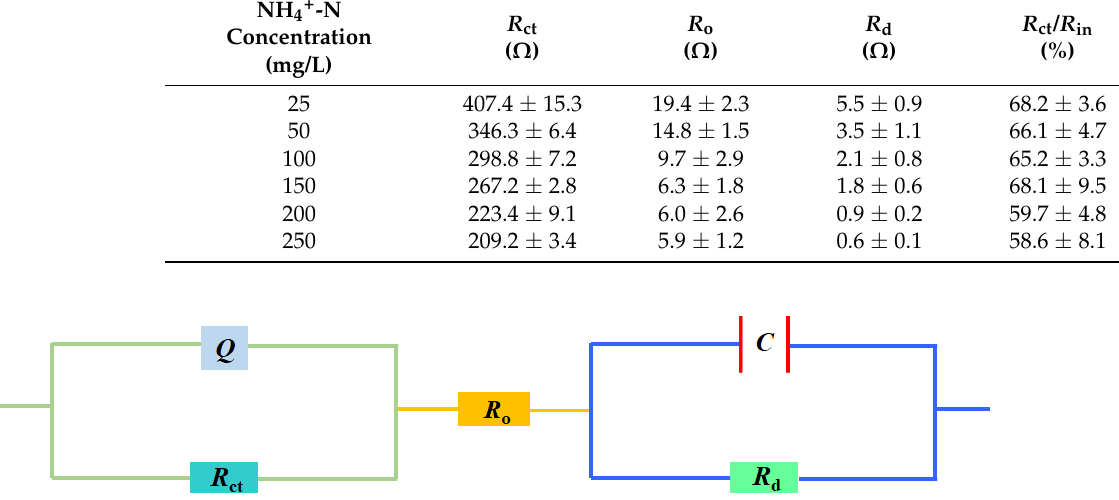
Figure 8. Equivalent electrical circuit for the electrochemical impedance spectra data simulation ( Q is the constant phase element and C stands for double ‐ layer capacitor). Table 2. Resistance distribution of the anode obtained from the equivalent electrical circuit.